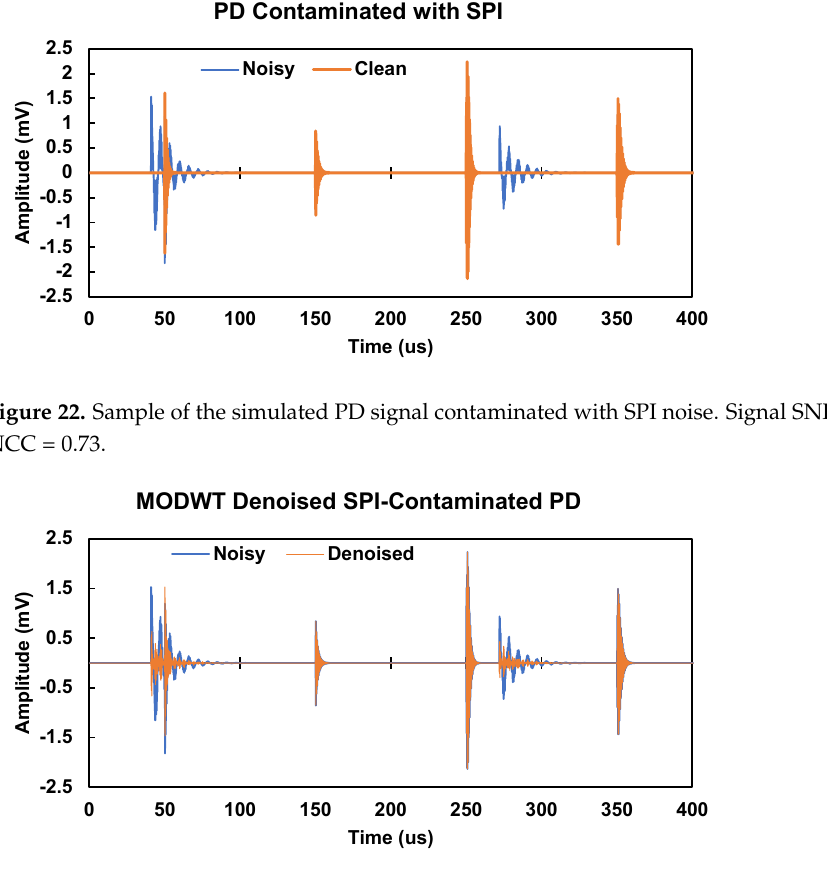
Figure 23. Denoised PD signal contaminated with SPI using MODWT. Input and output SNR = 3.4 dB and 12.18 dB, respectively. Input and output NCC = 0.73 and 0.96,